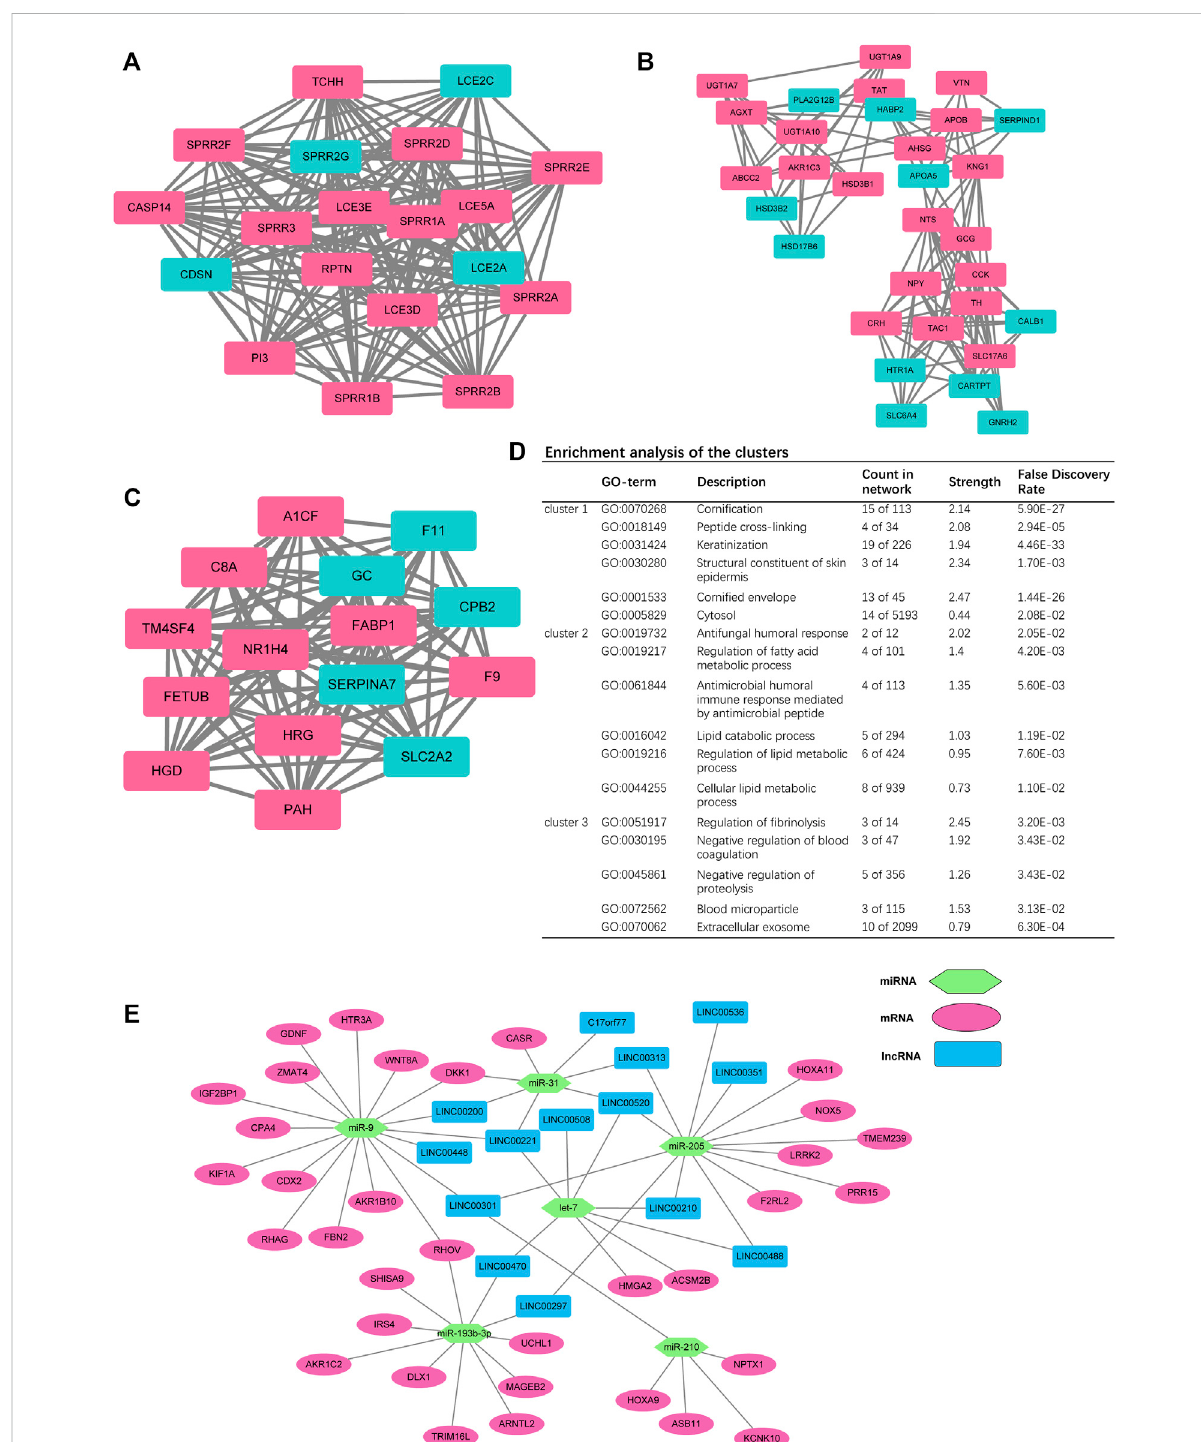
FIGURE 6 (A – C) Top three clusters in the protein-to-protein interaction (PPI) network. (D) Enrichment analysis of the top three clusters. (E) Competing endogenous RNA (ceRNA) network of RS-related DEGs - differentially expressed miRNAs — differentially expressed